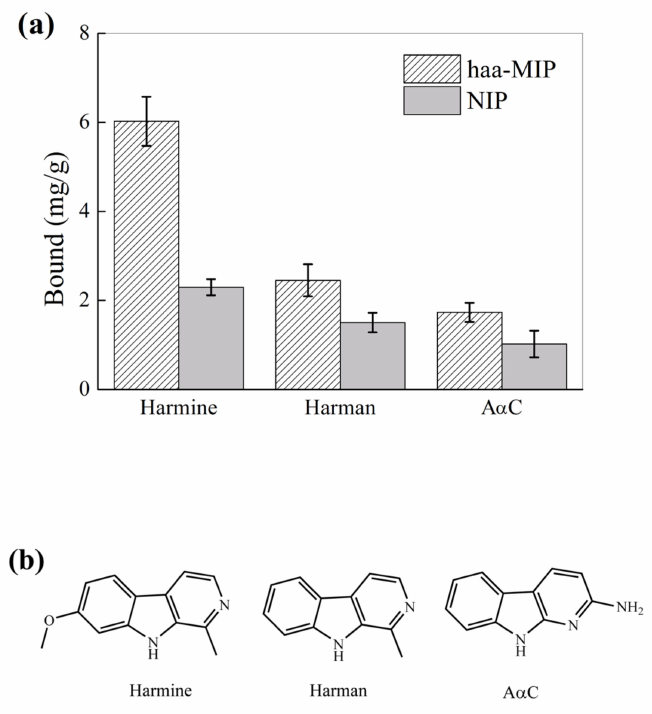
Figure 8. ( a ) Equilibrium binding of haa-MIP and NIP nanospheres toward harmine and its structural analogues (20 mg/L) in acetonitrile. ( b ) Chemical structure of harmine and its structural